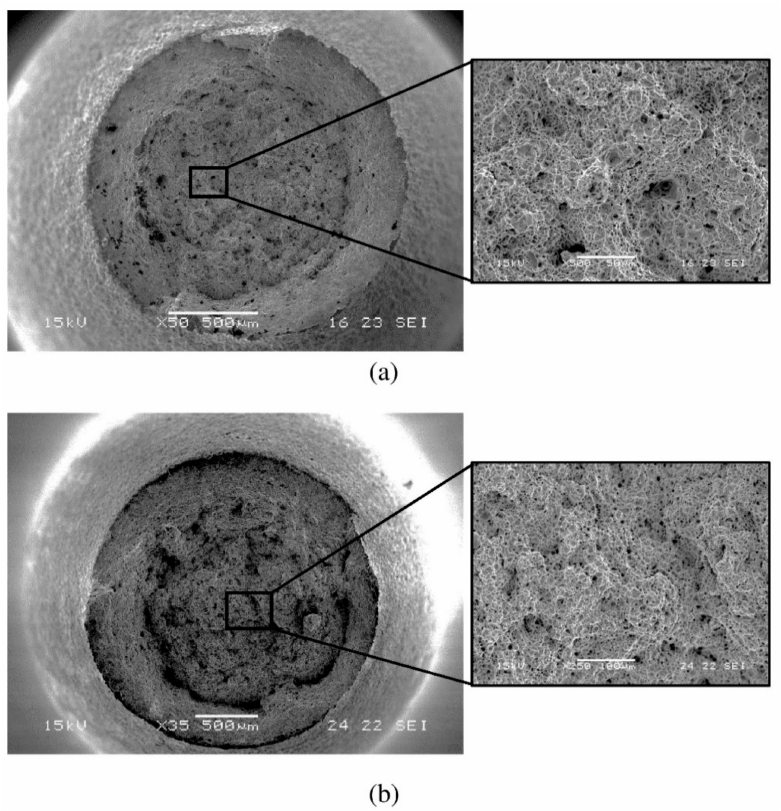
Figure 16. Typical fracture surface appearance obtained after SSRT at a strain rate of 2.5E-7 (1 / S) in 3.5% NaCl solution. ( a ) printed ER70S-6 alloy and ( b ) reference ST37